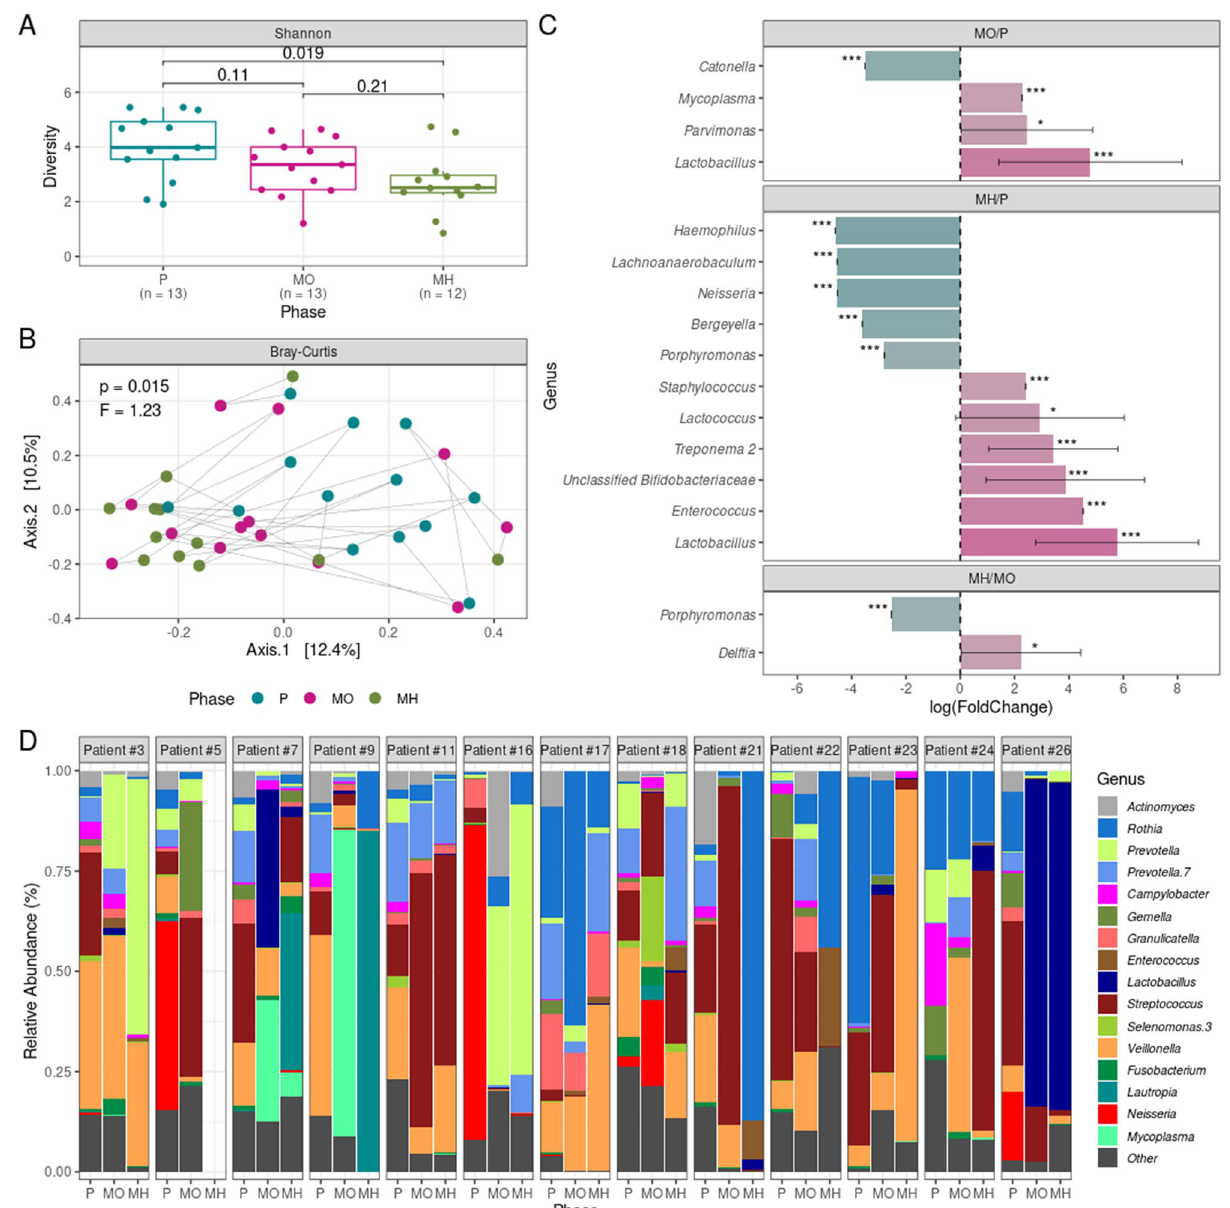
Figure 2. Changes in diversity and composition during oral mucositis (OM) clinical course. ( A ) Alpha- diversity boxplots at preconditioning (P), OM onset (MO), and OM healed (MH). Shannon was used as alpha- diversity metric. Statistical significance was evaluated by the Mann–Whitney U test, with P-values indicated. The boxes highlight the median value and cover the 25th and 75th percentiles, with whiskers extending to the more extreme value within 1.5 times the length of the box. ( B ) Principal coordinates analysis showing changes in composition during OM clinical course (beta-diversity). Bray–Curtis was used as beta-diversity metric. Samples from the same patient are linked by a gray line. Statistical significance was evaluated by the PERMANOVA test, with P- and F-values indicated. ( C ) Significant alterations in genera abundances between collection timepoints according to the ANCOM-BC test. *Adjusted P-value < 0.05; ***adjusted P-value < 0.001. ( D ) Genera relative abundances for each OM patient across collection timepoints. Only genera with > 1% relative abundance in > 25% of the samples or > 20% relative abundance in at least one sample are